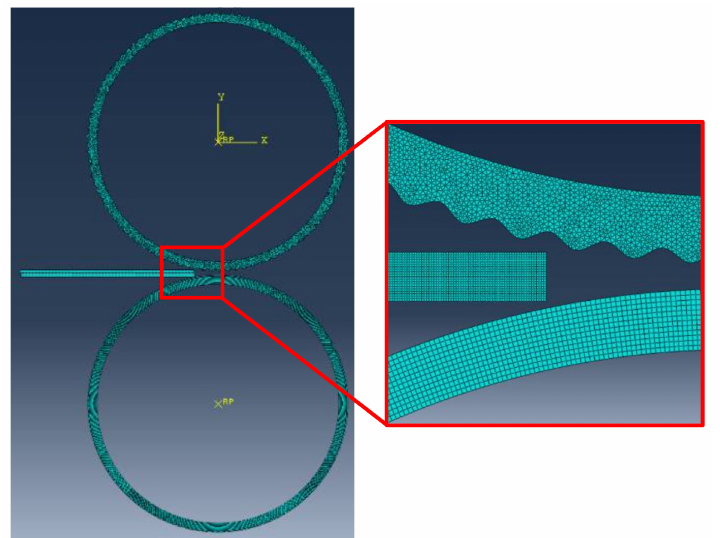
Figure 1. The meshing of the corrugated rolling process.